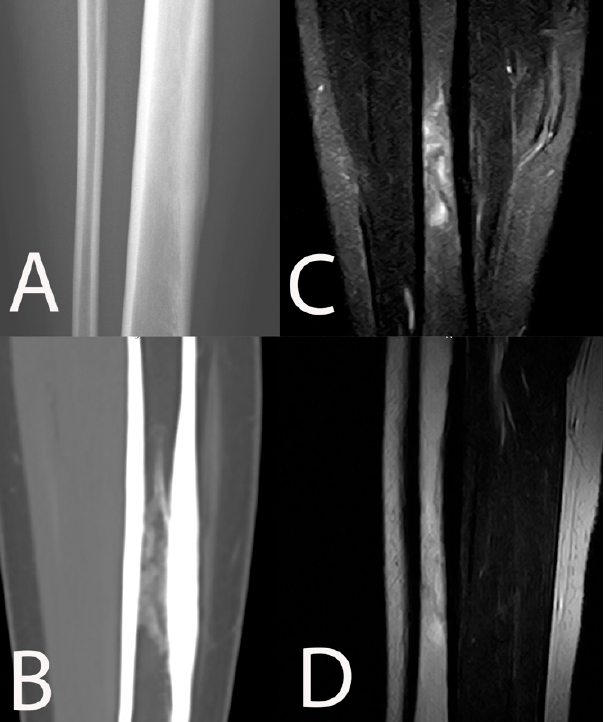
Figure 3. Chronic osteomyelitis of the tibia in a 16-year-old female. Periosteal reaction and sclerotic intramedullary focus are detectable on conventional radiography ( A ) and CT scan ( B ). MRI showed ill-defined bone edema among the sclerotic intramedullary changes on STIR coronal ( C ) and T1w sagittal ( D ).